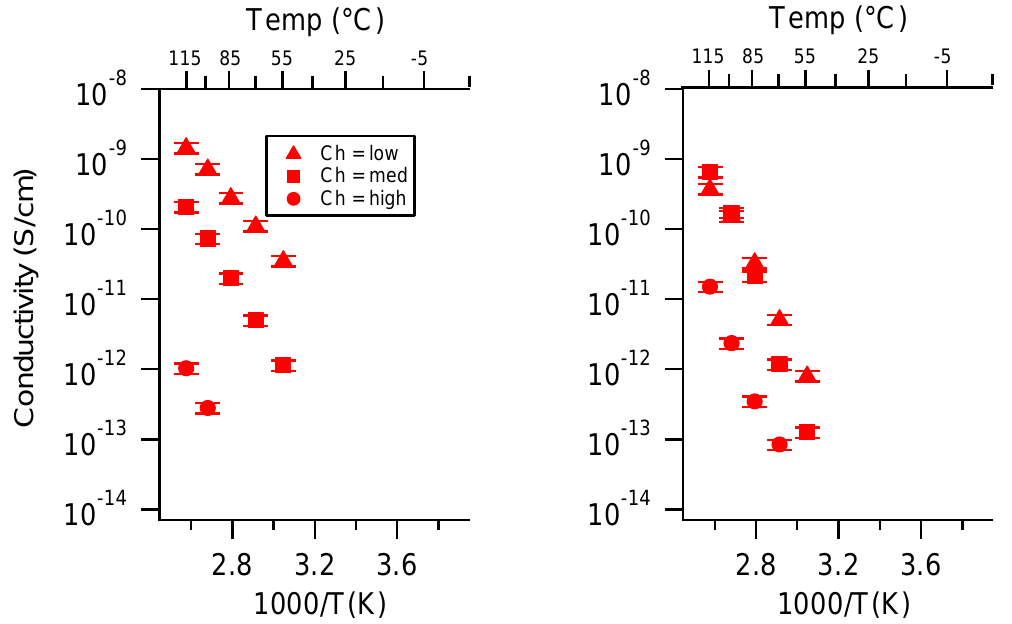
Figure A23. Conductivity as a function of charge density for PEGDMA1000_SSCa (left) and PTHFDA1000_STFSICa (right) SIPEs dry. Temperatures ranged from − 20 °C to 115 °C. Note that there may be a non ‐ negligible fraction of electronic conductivity in conditions where conductivity of less than 10 − 9 S/cm is reported.